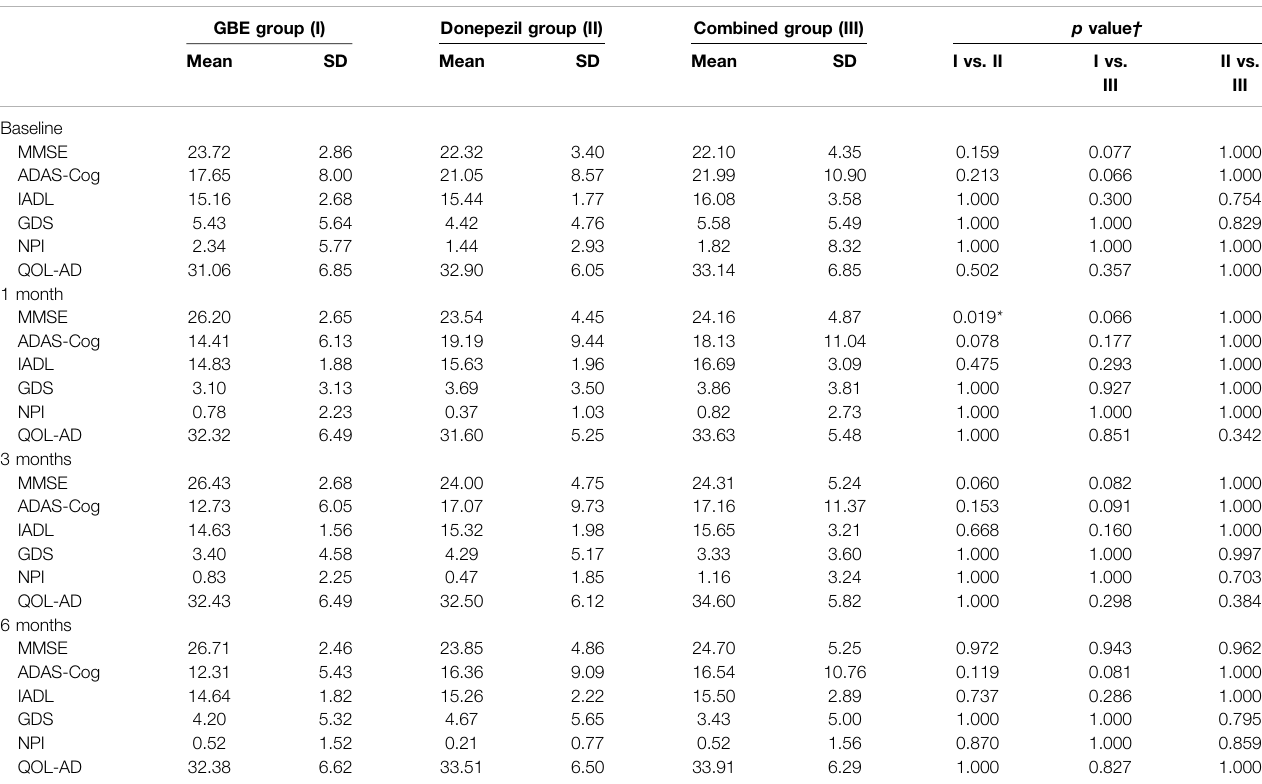
TABLE 2 | Intergroup outcome comparison across four visits. GBE group (I)